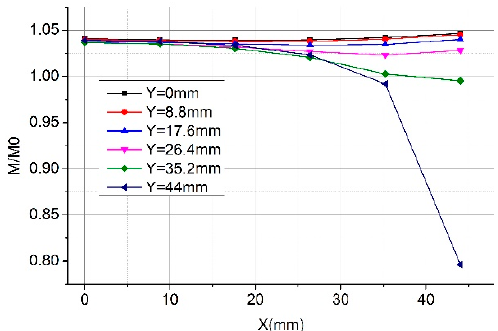
Figure 14. Calculation normalized mutual inductance between the Rogowski coil of rectangular skeleton and the D-shaped primary conductor.